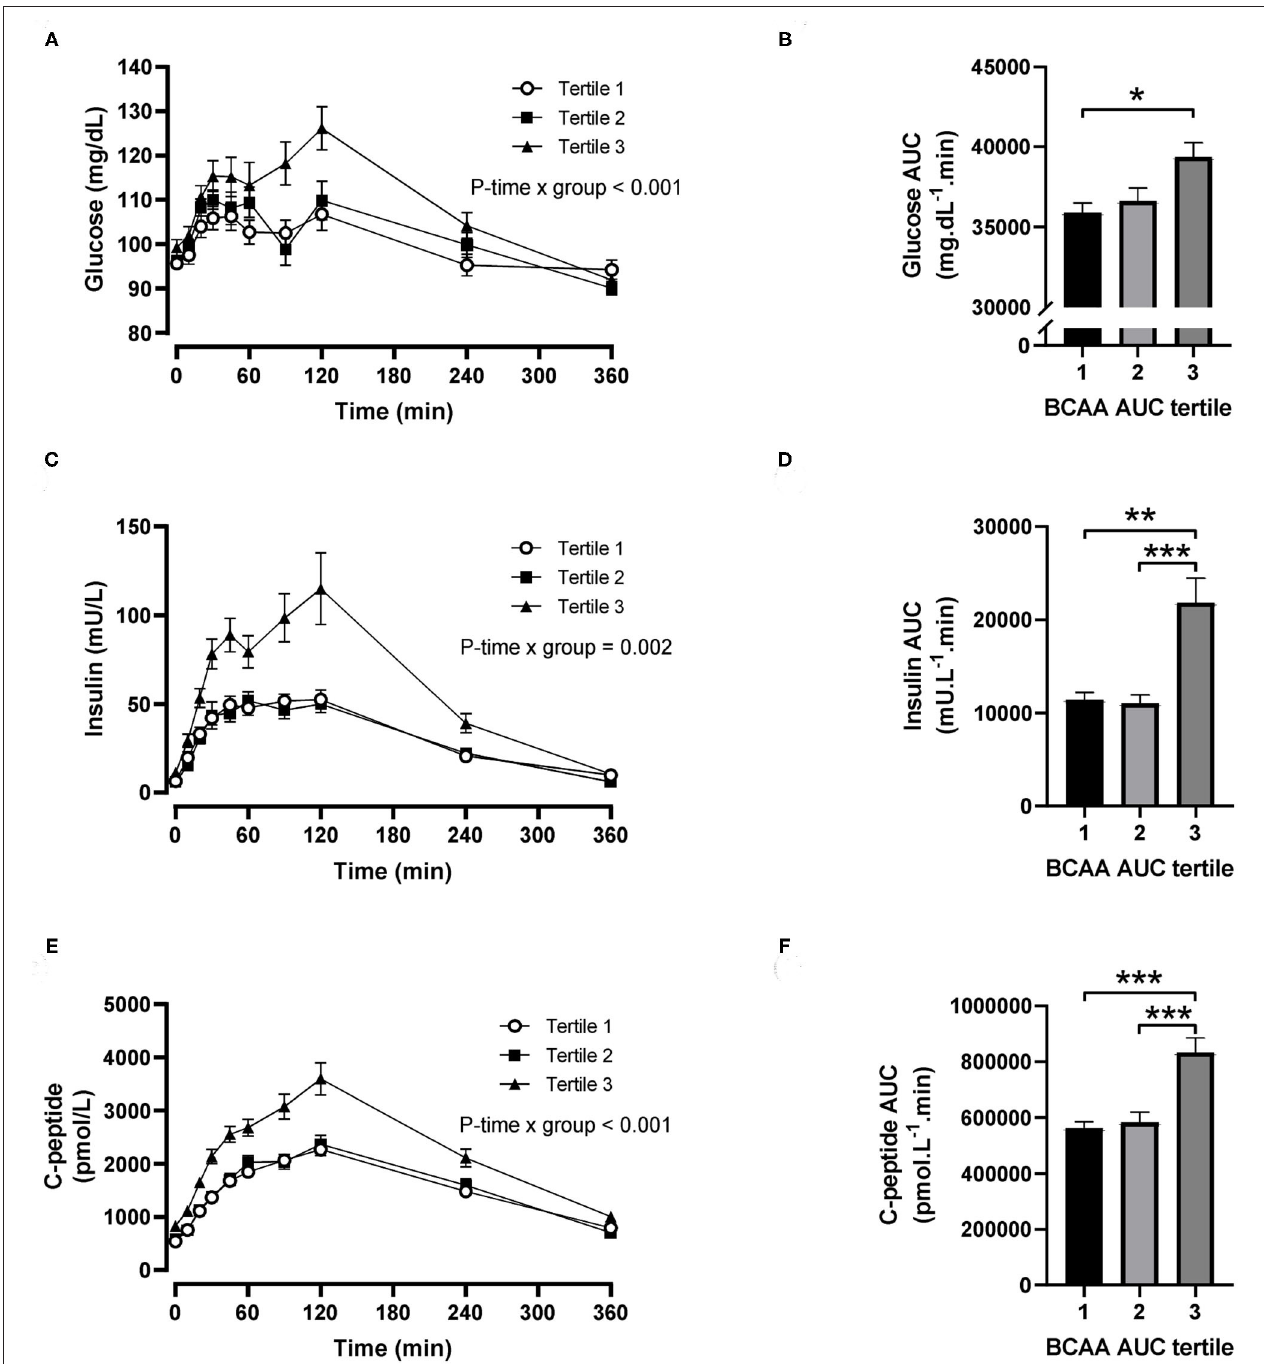
FIGURE 3 | Time courses and areas under the curve (AUC) of plasma glucose, insulin and C-peptide after ingestion of a mixed meal in subjects stratified in postprandial branched-chain amino acid (BCAA) AUC tertiles. Glucose (A,B) , insulin (C,D) and C-peptide (E,F) concentrations (linear mixed model) and AUCs (one-way ANOVA) after ingestion of a liquid mixed meal by postprandial BCAA AUC tertiles. Data are mean ± SEM; n = 31–32 per group. All analyses have been adjusted for sex and BMI. Corresponding values are significantly different between groups (Šidák-corrected): * P < 0.01, ** P < 0.05, *** P < 0.001.